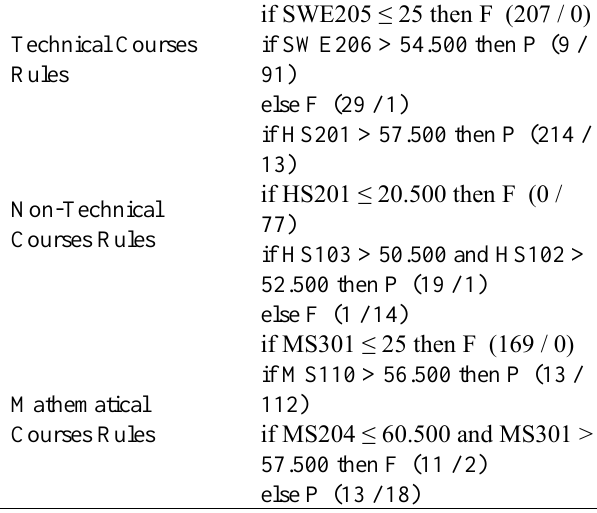
Results of Rule Induction for Dataset